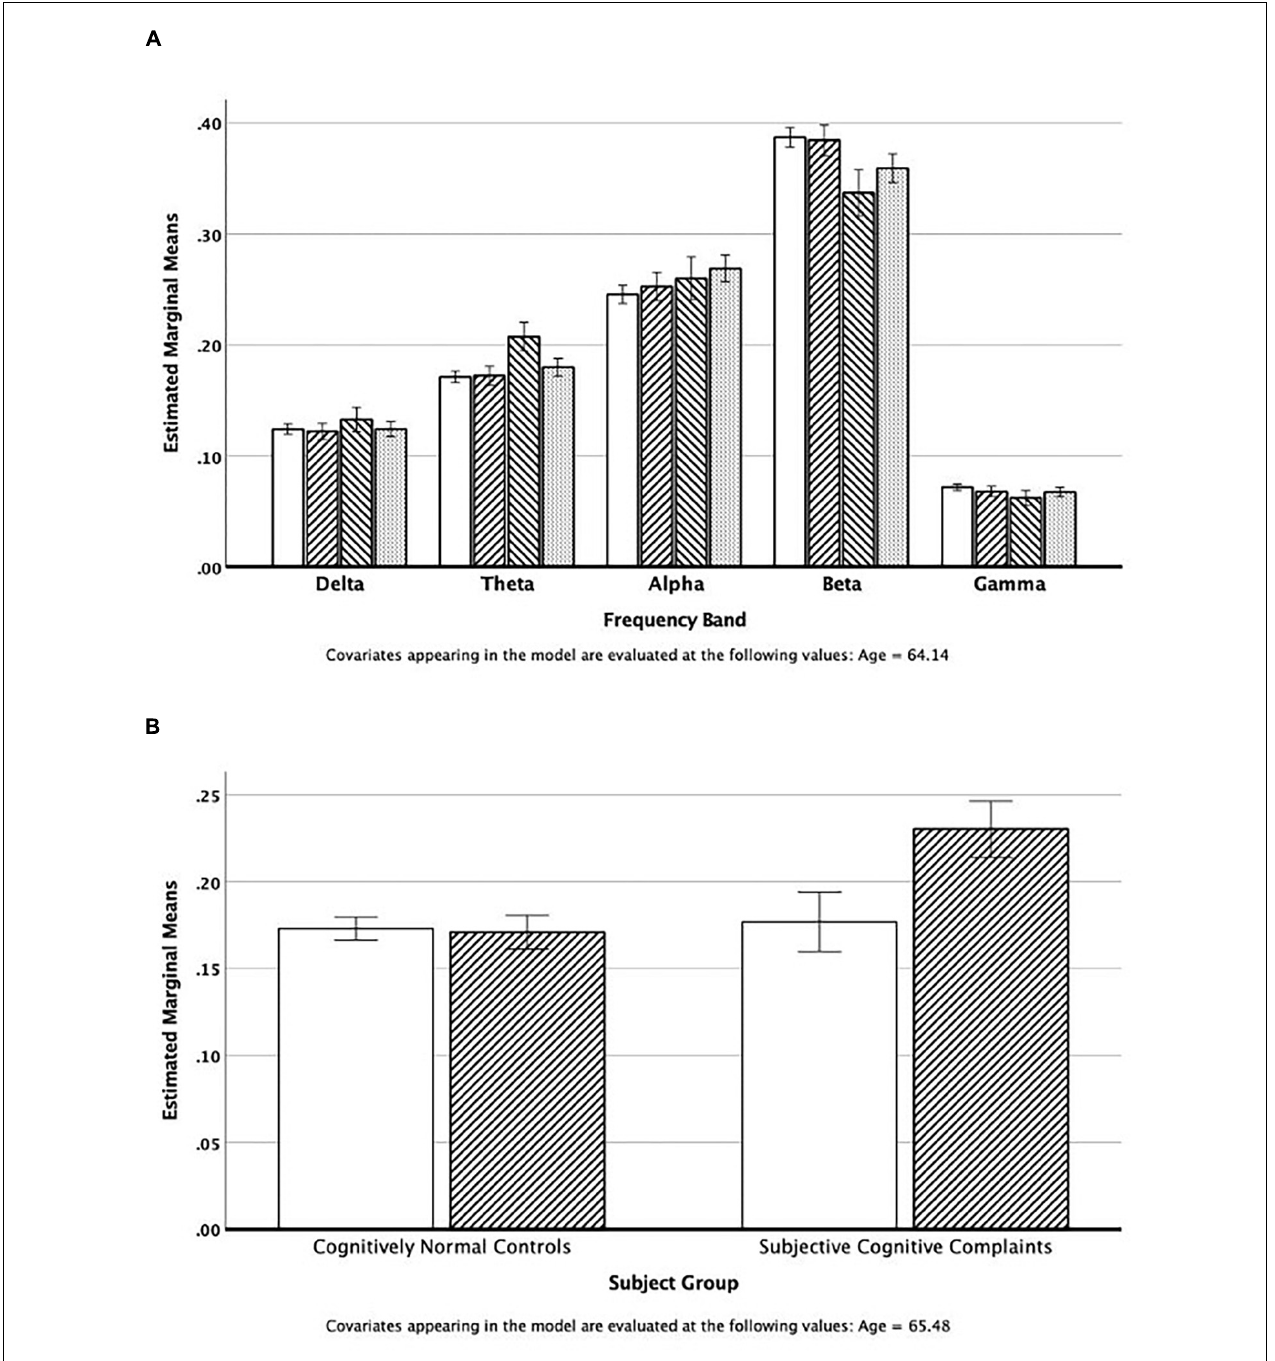
FIGURE 1 | (A) Estimated mean power in the five cortical regions adjusted for mean age of the group. The bars represent values for the Normal Controls, IWOC, SCC, and MCI groups, respectively. (B) Estimated theta band power in the temporal lobes adjusted for mean age. The open bars are those individuals classified as PiB − , and the cross-hatched bars are for those individuals who are PiB +